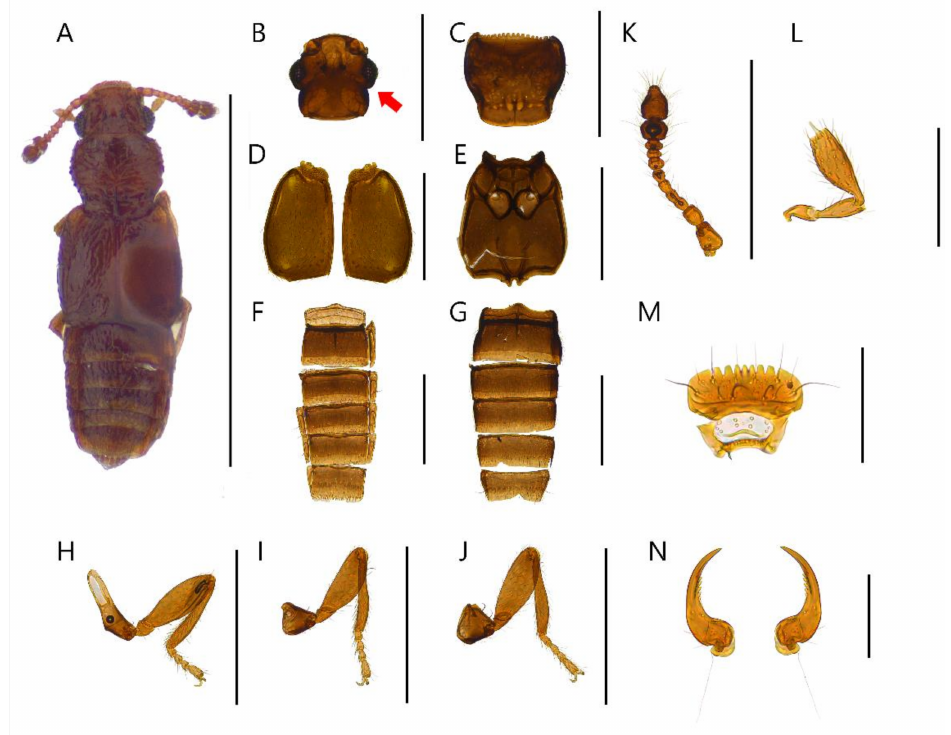
Figure 6. Male habitus of Edaphus lederi Eppelsheim: ( A ) dorsal view; ( B ) head; ( C ) pronotum; ( D ) elytra; ( E ) meso and metasternum; ( F ) abdominal tergites; ( G ) abdominal sternites; ( H ) fore leg; ( I ) middle leg; ( J ) hind leg; ( K ) antenna; ( L ) maxillary palp; ( M ) labrum; ( N ) mandibles. Scale bars: ( A ) = 1 mm; ( B – K ) = 0.3 mm; ( L – N ) = 0.1